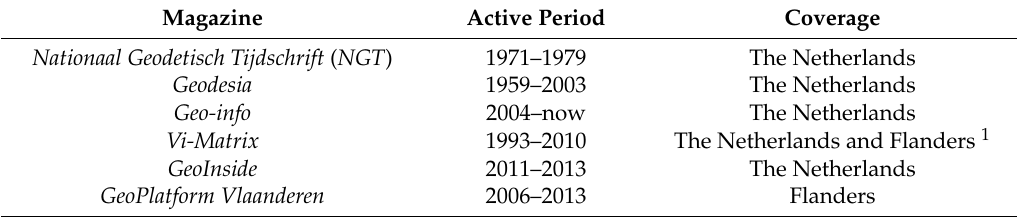
Table 1. Overview of the Dutch geo-information magazines used as research